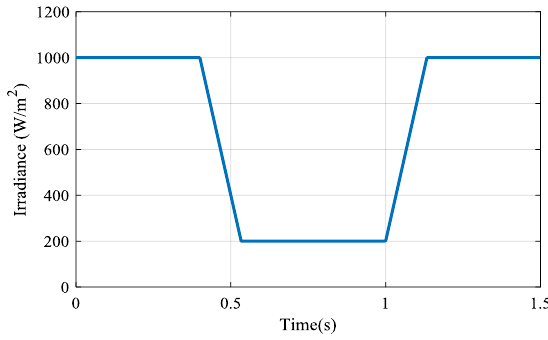
Figure 9. Changes of